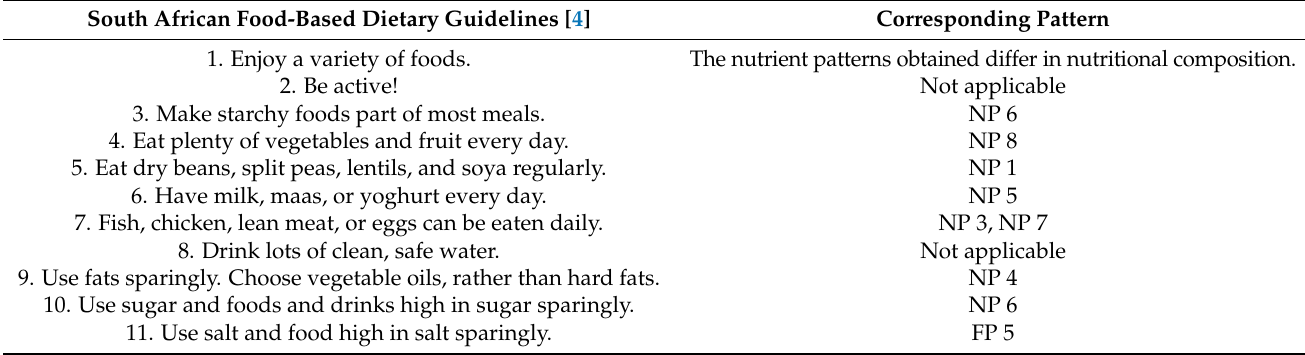
Table 6. Comparison between the South African food-based dietary guidelines and principal component analyses. South African Food-Based Dietary Guidelines [4]